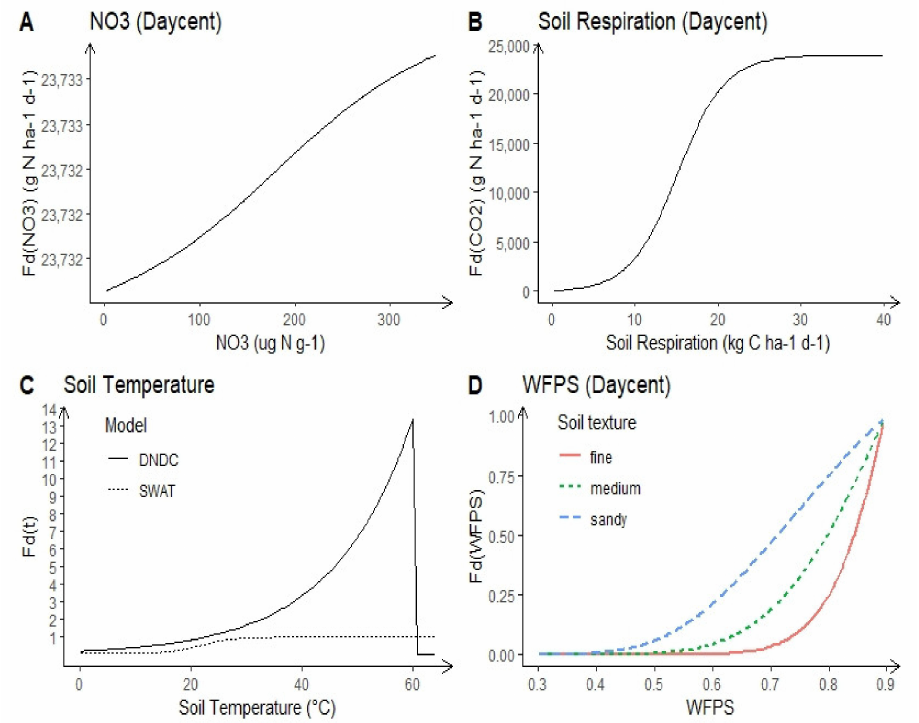
Figure 5. The impact of soil NO 3 − ( A ), soil respiration ( B ), soil temperature ( C ), and WFPS ( D ) on denitrification processes in DAYCENT, DNDC and